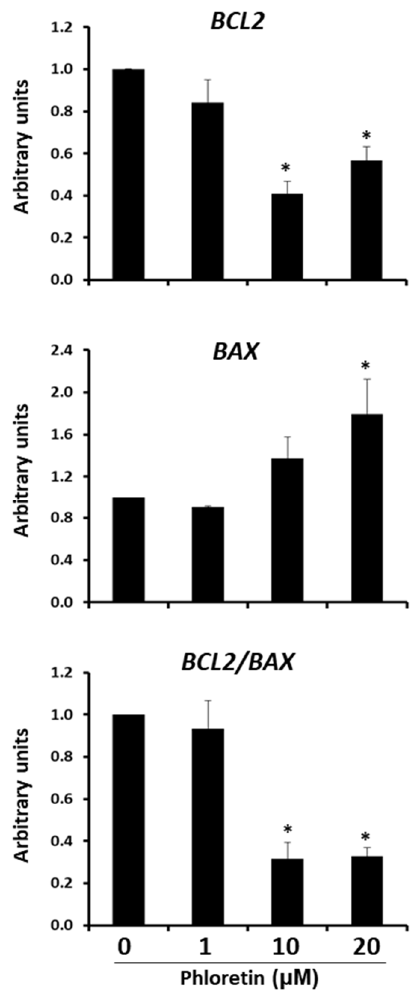
Figure 8. Gene expression of BCL2 anti-apoptotic and BAX apoptotic genes, 13 days after beginning adipogenic differentiation of MSC cultures, in presence of 0, 1, 10, and 20 µM of phloretin. BCL2/BAX ratio is also represented. * p < 0.05 vs. cultures no treated (0 µM of phloretin).